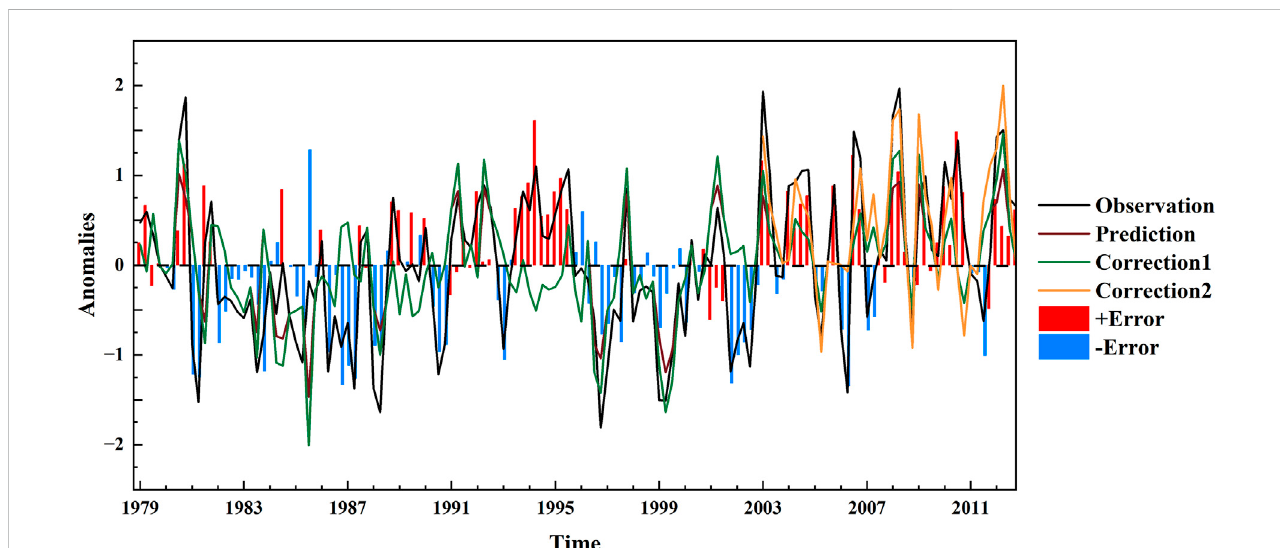
FIGURE 7 Observation, simulation by the model with Group 3 factors, and two corrections of Weddell Sea SIC anomaly in fi tting period (unit: %). Correction1 represents the fi rst error correction method shown in Eq. 9, and Correction2 represents the second method from Eq. 10. The blue and red histograms represent the positive and negative errors, respectively, between observation and simulation of SIC. The abscissa denotes the calendar